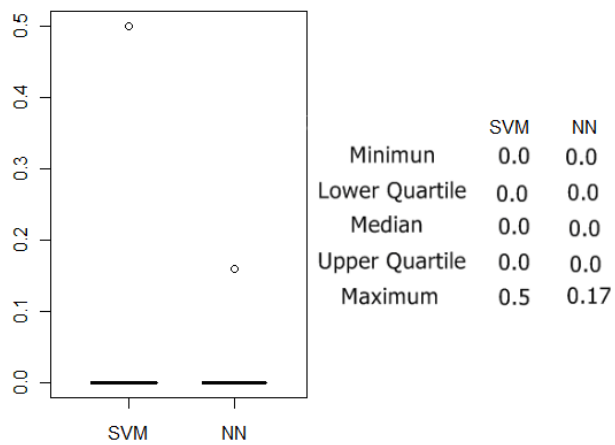
Figure 10. Boxplot of the error calculated over the test